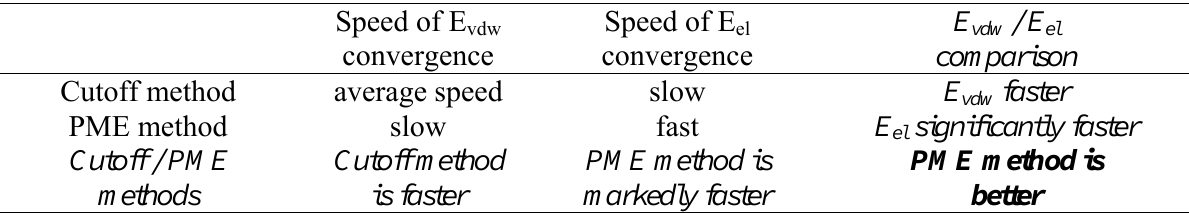
Table 10. Summary of results for nucleotide-sugars.